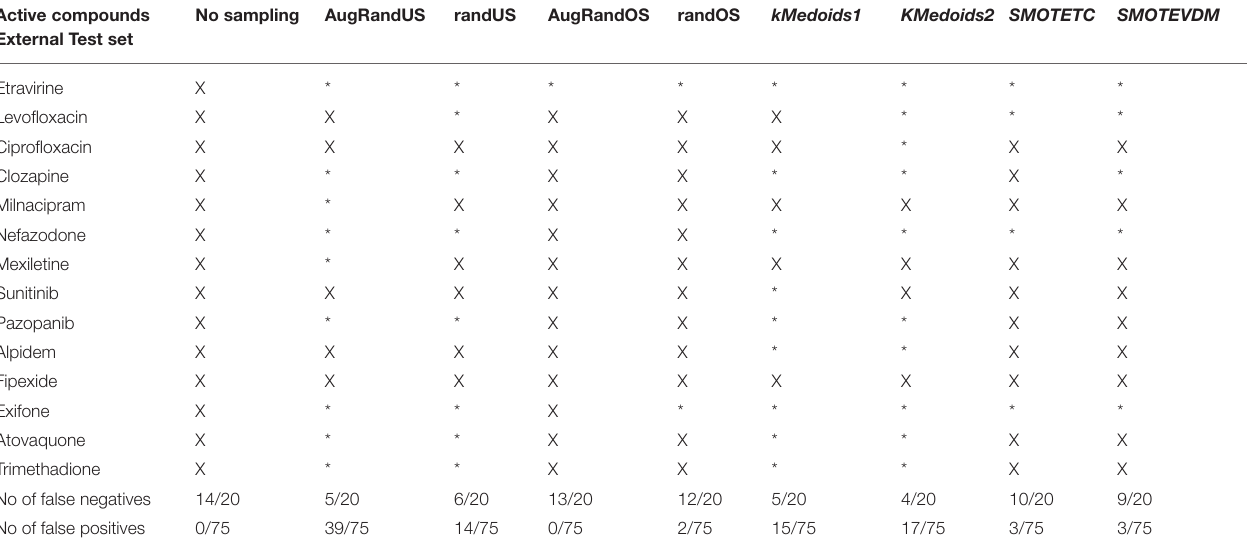
TABLE 3 | Total number of false positives and false negative predicted by different non/sampling methods for DILI model based on Random Forest classifier and MACCS fingerprints. Active compounds No sampling AugRandUS External Test set